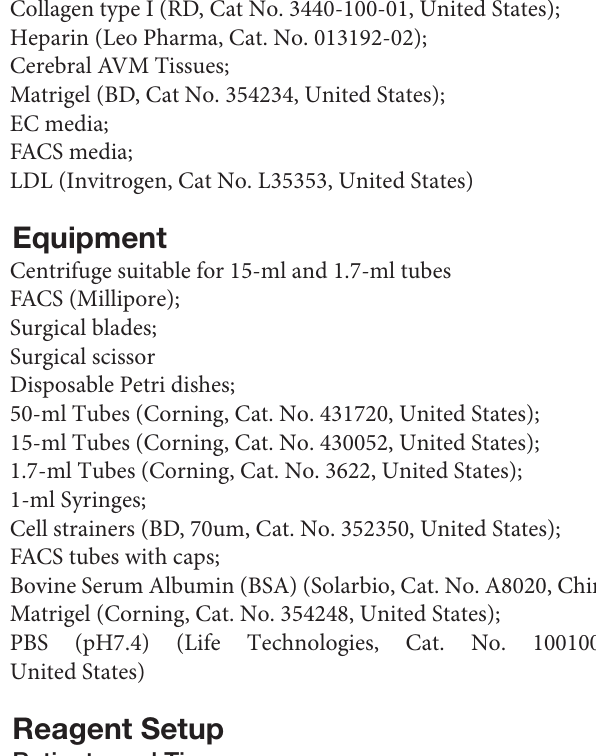
Dil-labeled acetylated LDL (Invitrogen, Cat No.